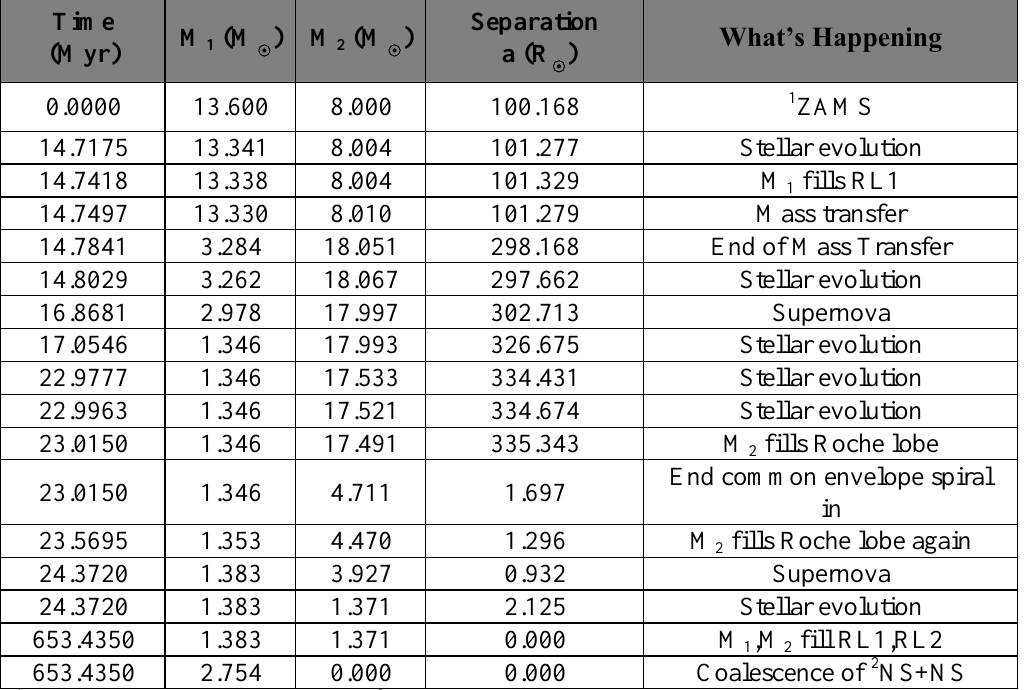
Table 1: The evolutionary stage of binary star system(13.6+8)M Time